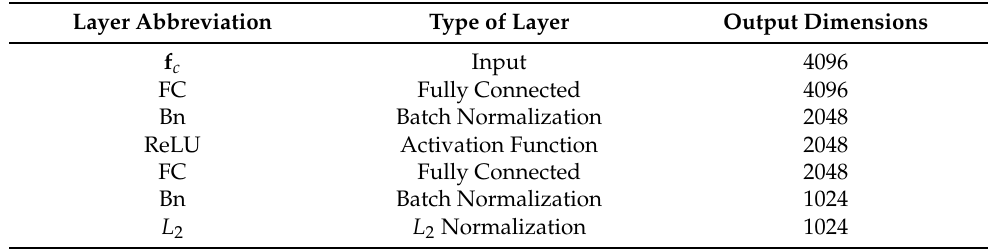
Table 1. Description of the used layers with their corresponding output dimensions after the concatenation procedure. This part of the model is shown in Figure